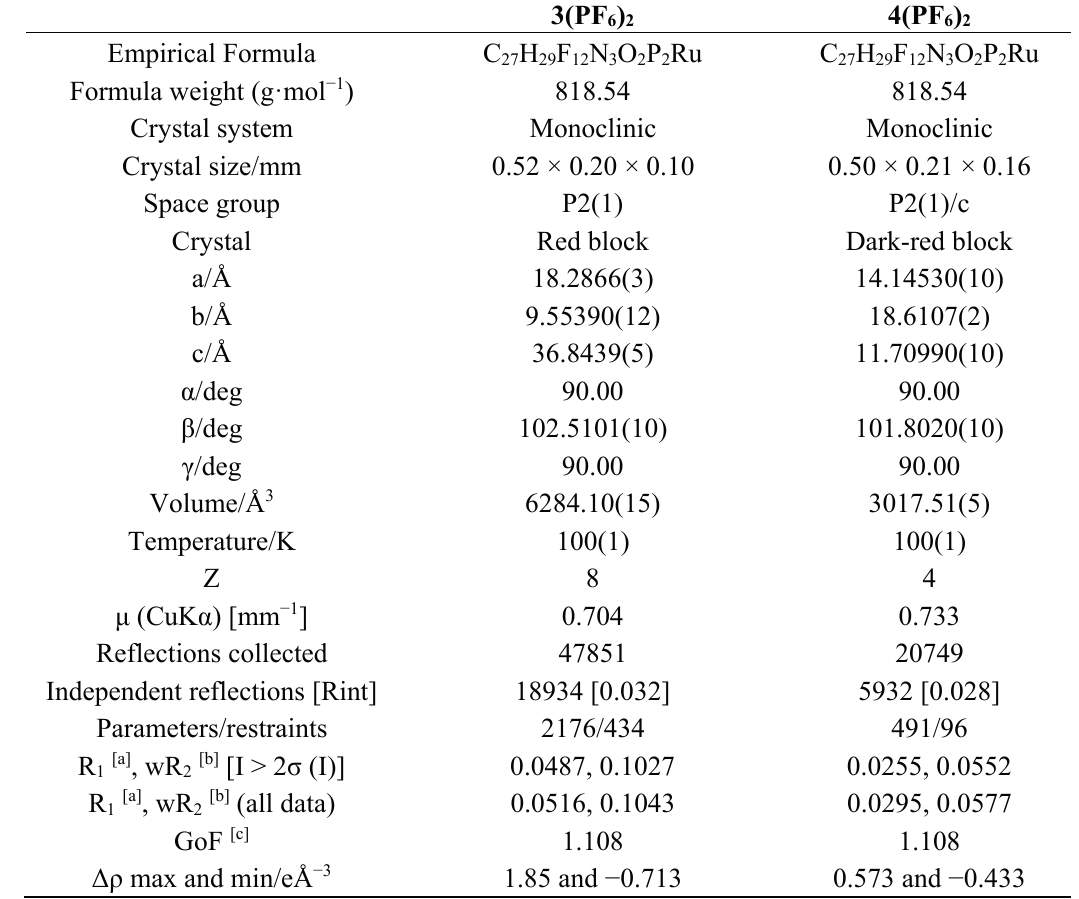
Table 1. Crystal data and structural refinement parameters for 3 and 4 .